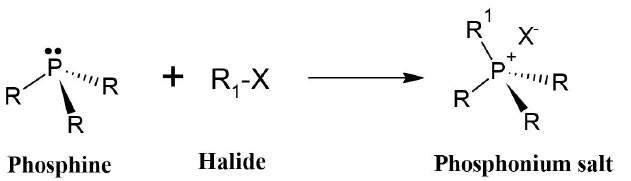
Figure 7. Nucleophilic substitution reaction between phosphine and halide.